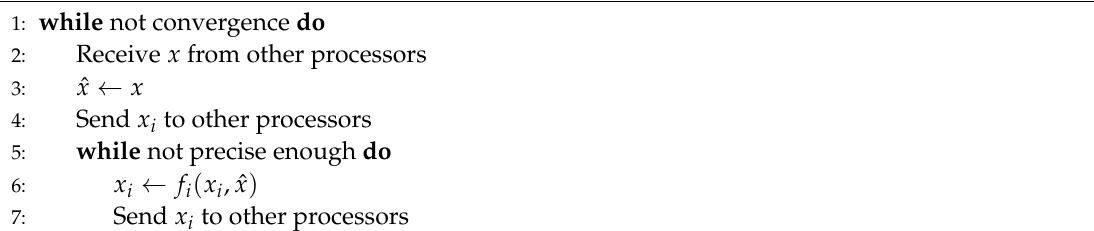
Algorithm 2 Asynchronous two-stage iterations with flexible